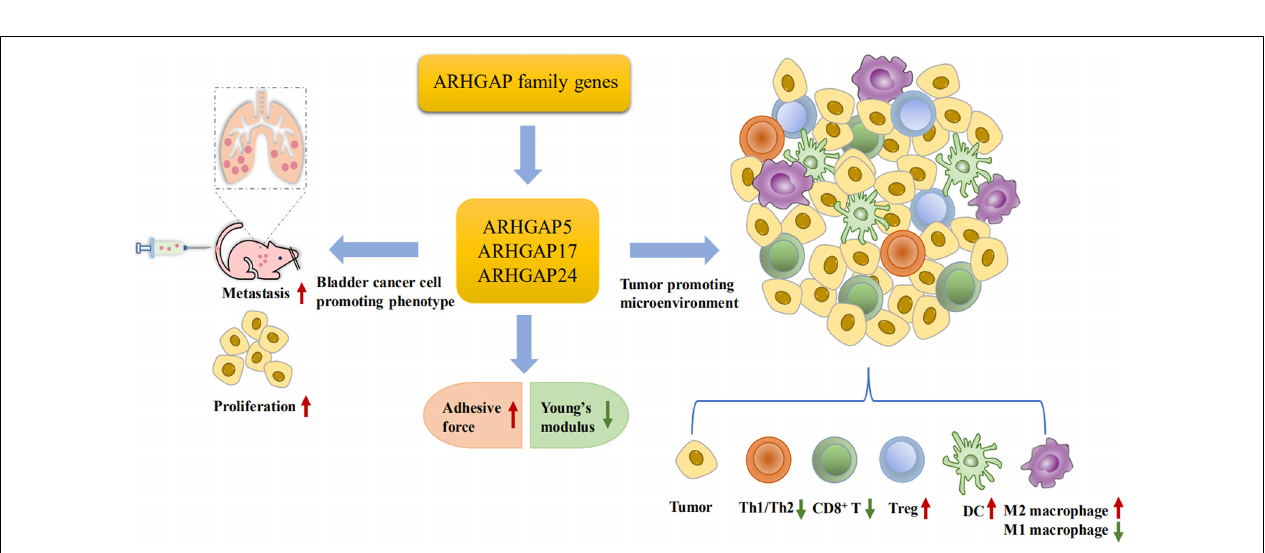
FIGURE 10 | Scheme of ARHGAP family gene promotes BC progressing through establishing a tumor-promoting microenvironment and promotes BC cell proliferation, migration, and metastasis though cellular mechanical property-mediated cell motility.